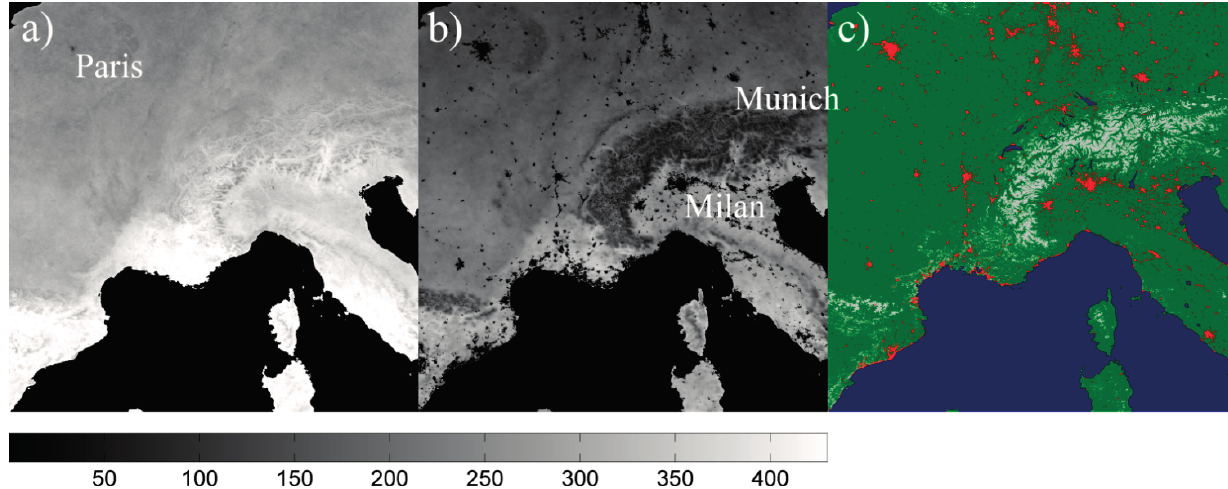
Figure 3. Number of cloud free scenes for the period 2011–2012 for tile h18v04 for ( a ) all produced acquisitions; ( b ) acquisitions with good (“00”) quality flag; ( c ) Urban areas (red) according to MODIS land cover dataset.